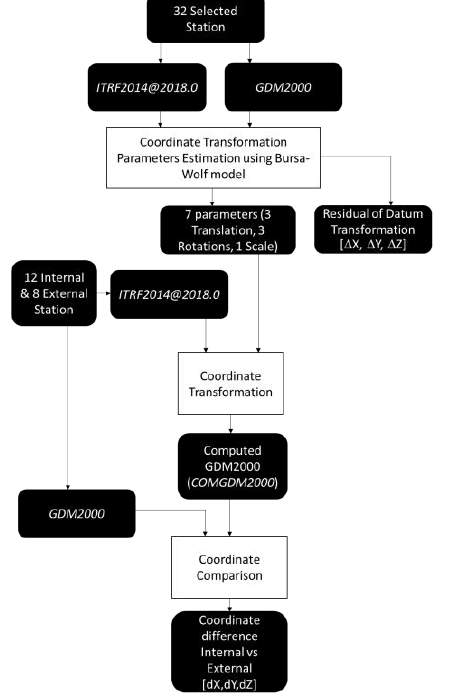
Figure 2 . Dependent Stations.